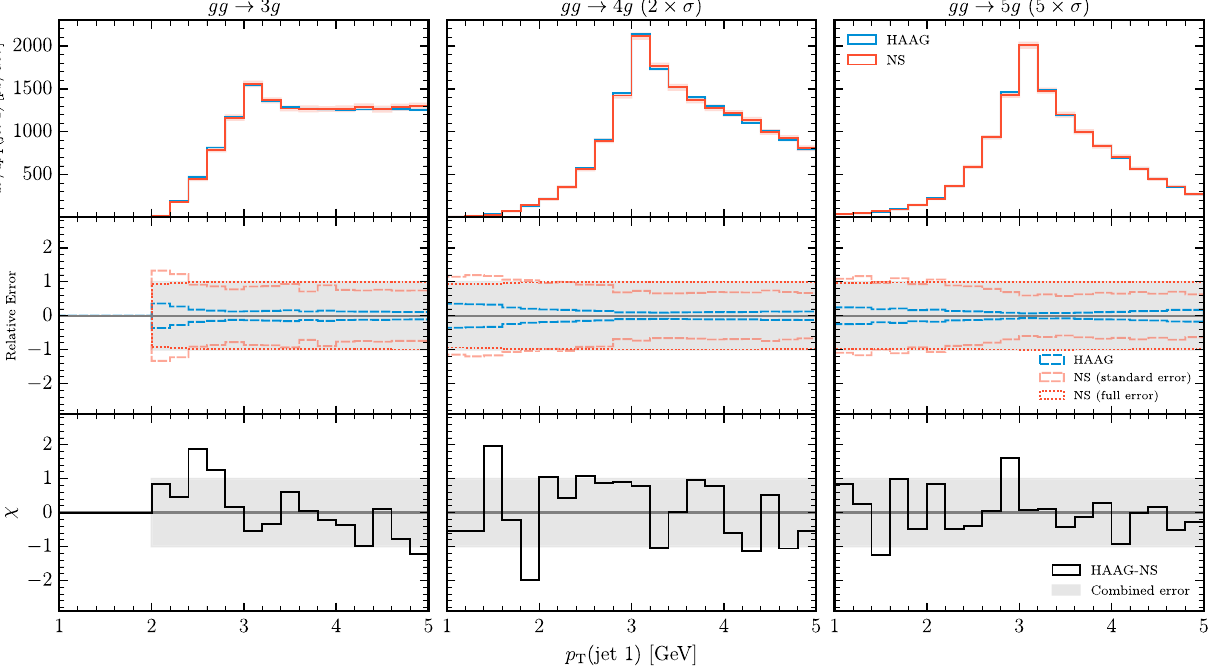
Fig. 5 Two example physical differential observables computed with weighted events using the H AAG and NS algorithms. The top panels show the physical distributions, the middle panels display the relative component error sources, and the bottom panel displays the normalised